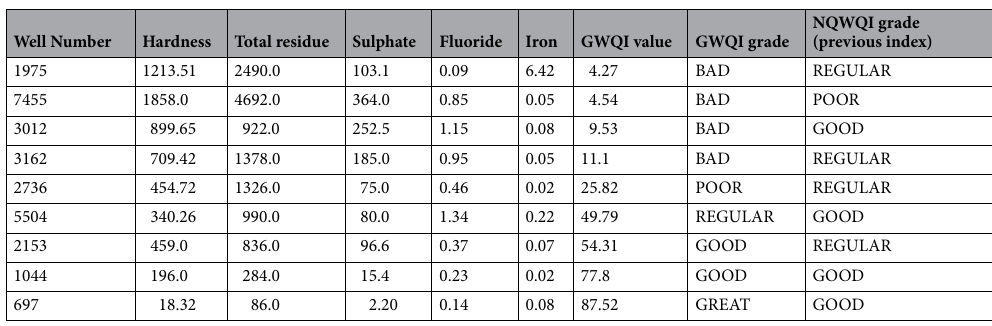
Table 9. Ten values of the GWQI calculations with the Eq. (1) and grades from the GWQI and the NGWQI previously derived. Drinking water standards (Brazil 2011): hardness = 500 mg/L; total residue = 1000 mg/L; sulphate = 250 mg/L; fluoride = 1.5 mg/L; iron = 0.3